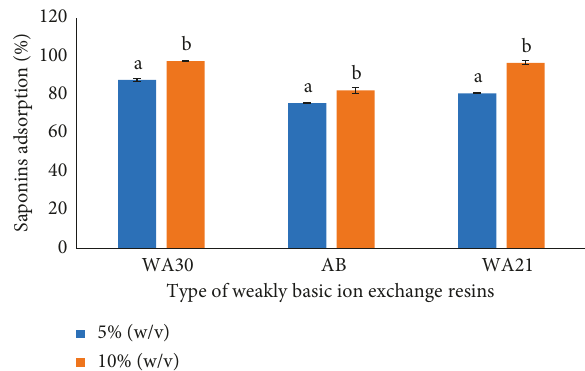
Figure 5: Effect of adsorbent dose at 5% (w/v) and 10% (w/v) on the saponin adsorption (%) of three different types of weakly basic ion exchange resins. a, b: different alphabets indicate a significant difference ( p 0 . 05). 0 . 05). < <